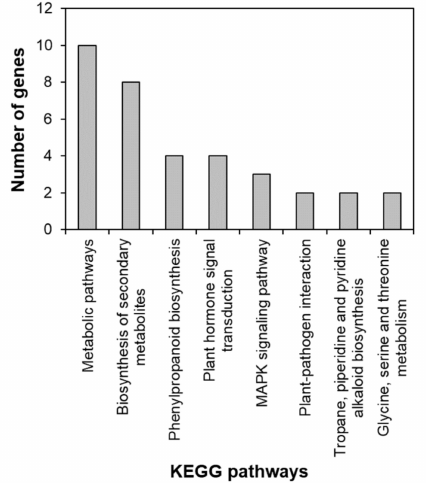
Figure 3. KEGG pathway of downregulated genes in AtRH17 OXs. KEGG pathway was analyzed using KEGG Mapper.